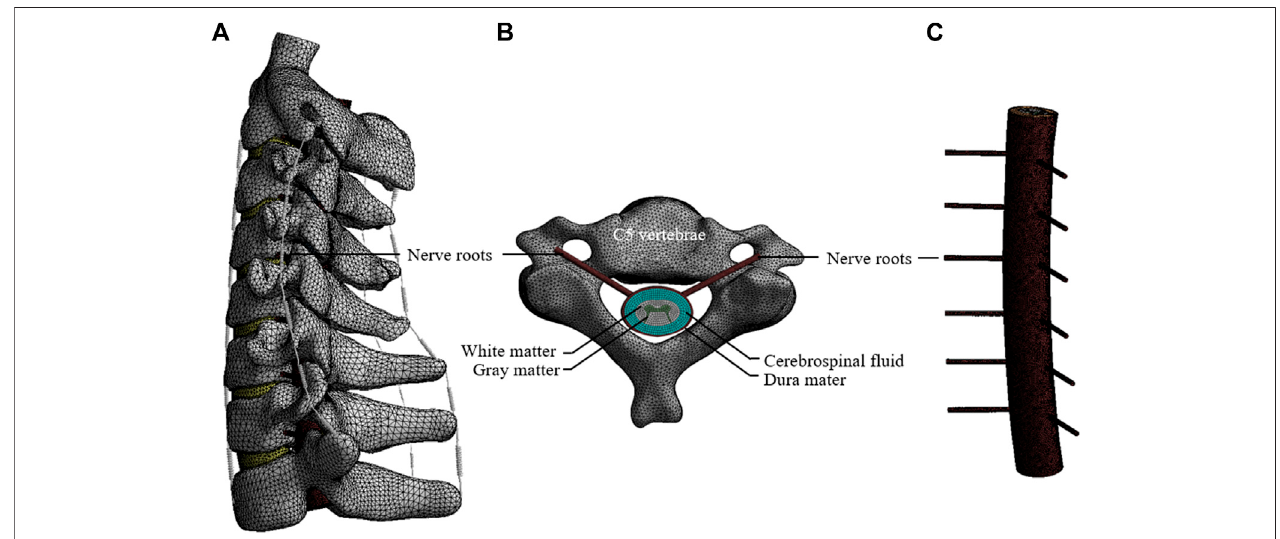
FIGURE1| TheFEmodeloftheC2 – T1. (A) TheFEmodelofthecervicalspineandspinalcord. (B) AxialviewofthespinalcordattheC5vertebrae. (C) Lateralview of the spinal cord model.